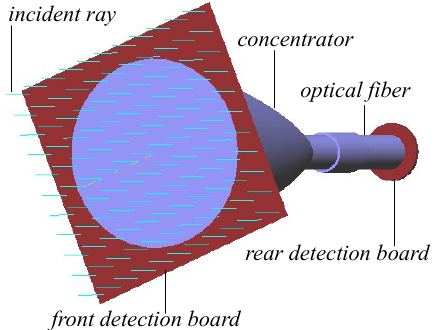
Figure 5. Schematic diagram of ray number detection.